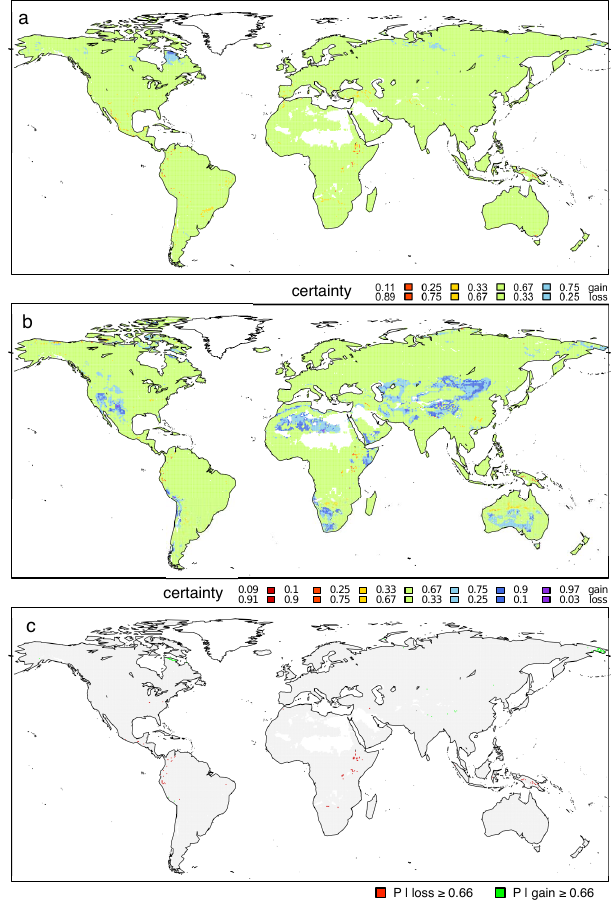
Figure 6. Certainty of changes of SOC stocks using (a) limited NPP and (b) enhanced NPP. (c) Consensus: locations where certainties of both scenarios are > 0.66 ( P limited > 0.66 and P enhanced >